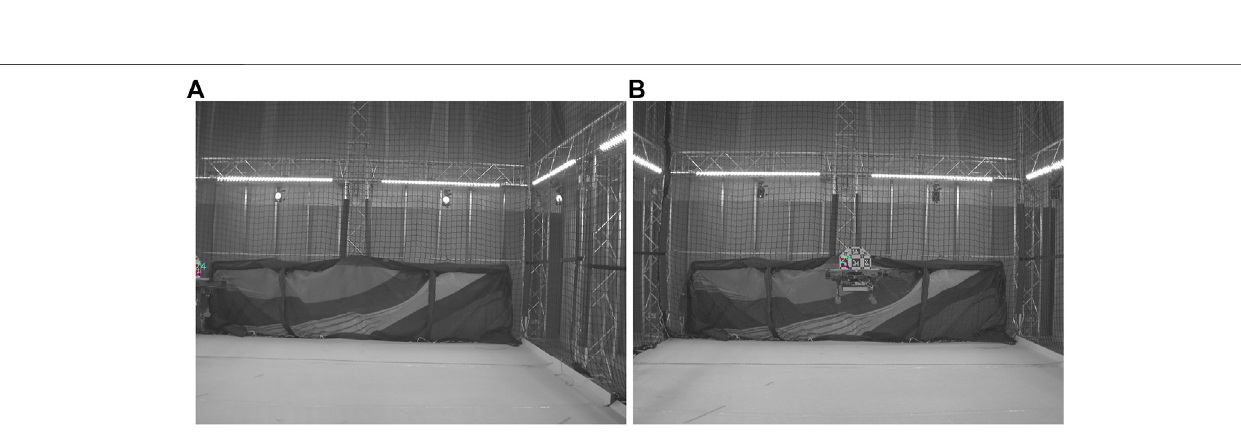
Frontiers in Robotics and AI |